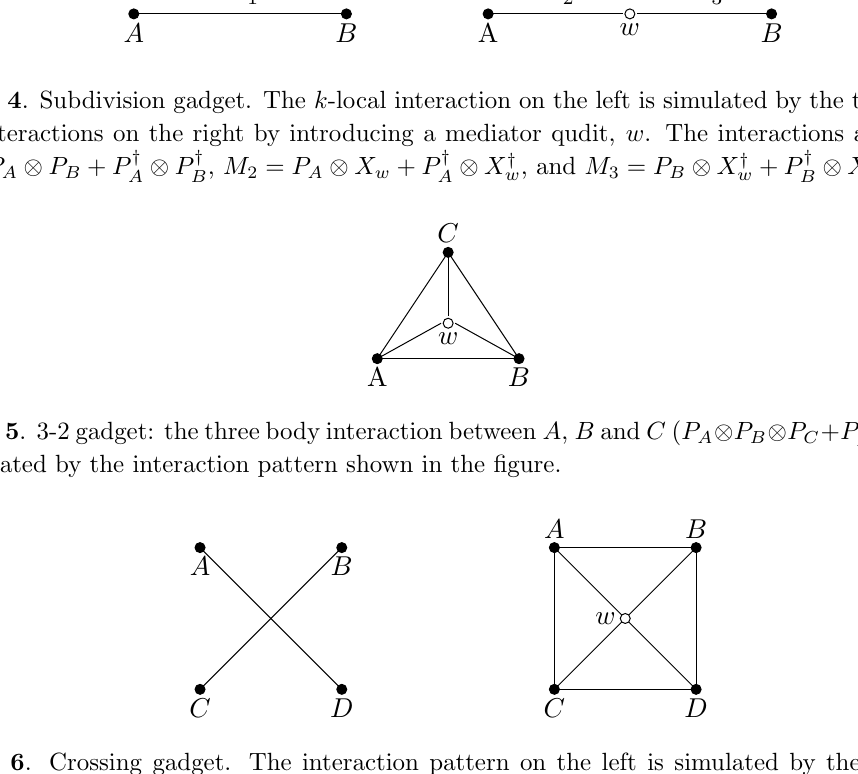
Figure 6 . Crossing gadget. The interaction pattern on the left is simulated by the interaction pattern on the